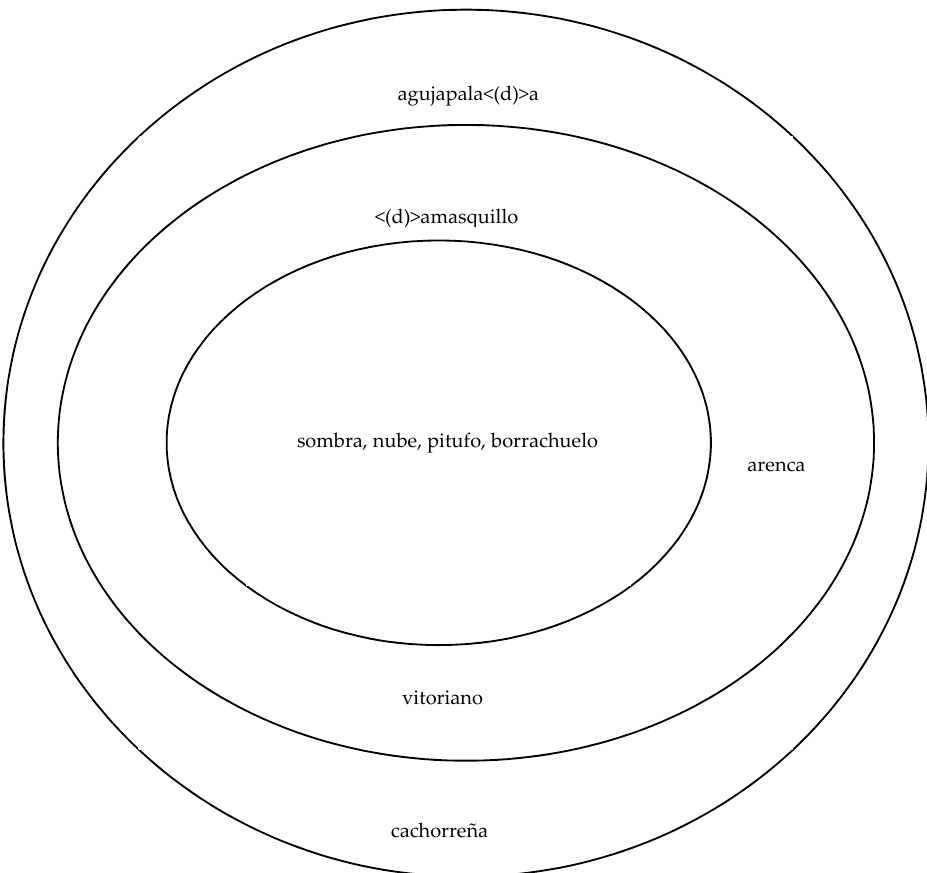
Figure 3. Model of crowns for the lexical proximity selection based on frequency of use (Food and drink) (Ávila-Muñoz 2017).